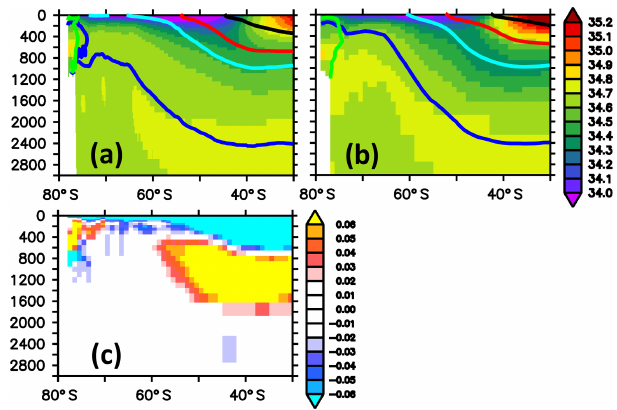
Figure 19. Zonally averaged meridional section of salinity. Panel (a) refers to simulated salinities averaged over the nominal 1993–1998 period of the reference simulation. Panel (b) refers to observed climatological salinities (WOA09). Panel (c) refers to the difference between simulated and observed values, with blue colors denoting simulated salinities that are biased low. The thick black, red, cyan, blue and green contours refer to mean densities (Sallée et al., 2013b, their Table 2) of subtropical water, mode water, interme- diate water, circumpolar deep water and bottom water,